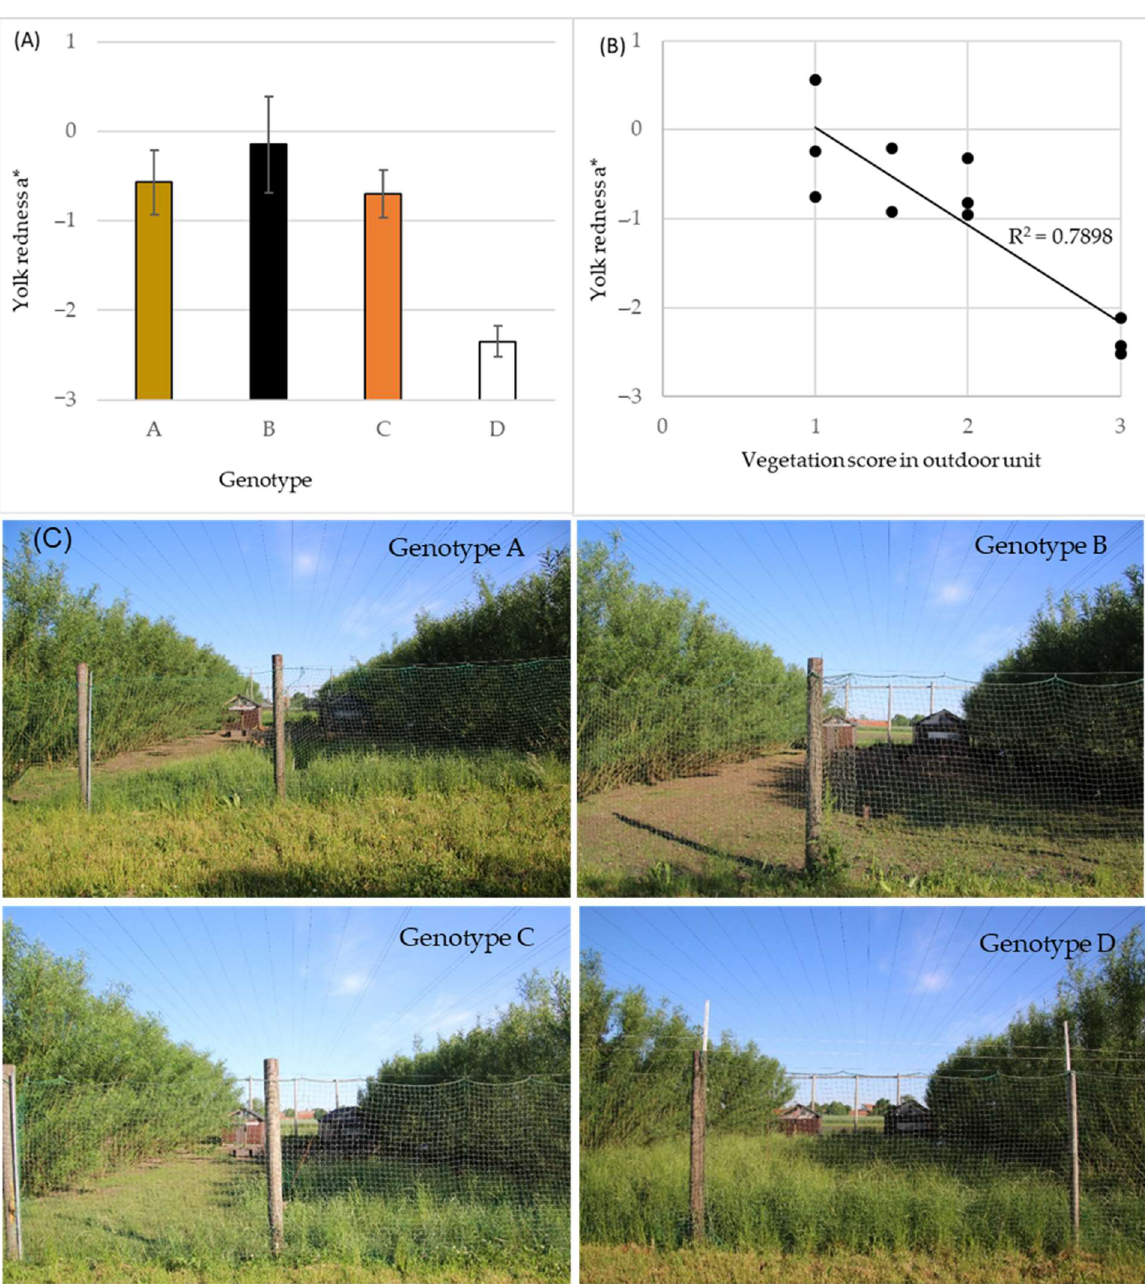
Figure 4. (A ) LS-mean egg yolk color redness a* at hen age 30 week for four hen genotypes A–D, n = 30 for genotype A and 45 for genotypes B, C and D, vertical bars indicate standard deviations. ( B ) Correlation of scores for visual evaluation of vegetation coverage in outdoor units of organic poultry 3 weeks prior to egg collection and yolk color redness a* of panel A data. Each data point represents one pen and 15 egg yolk colors. Score 1 = mainly bare soil, 2 = partly covered with vegetation, 3 = full covered with vegetation. ( C ) Representative photos of outdoor units for hen genotypes A–D at time for vegetation scoring.